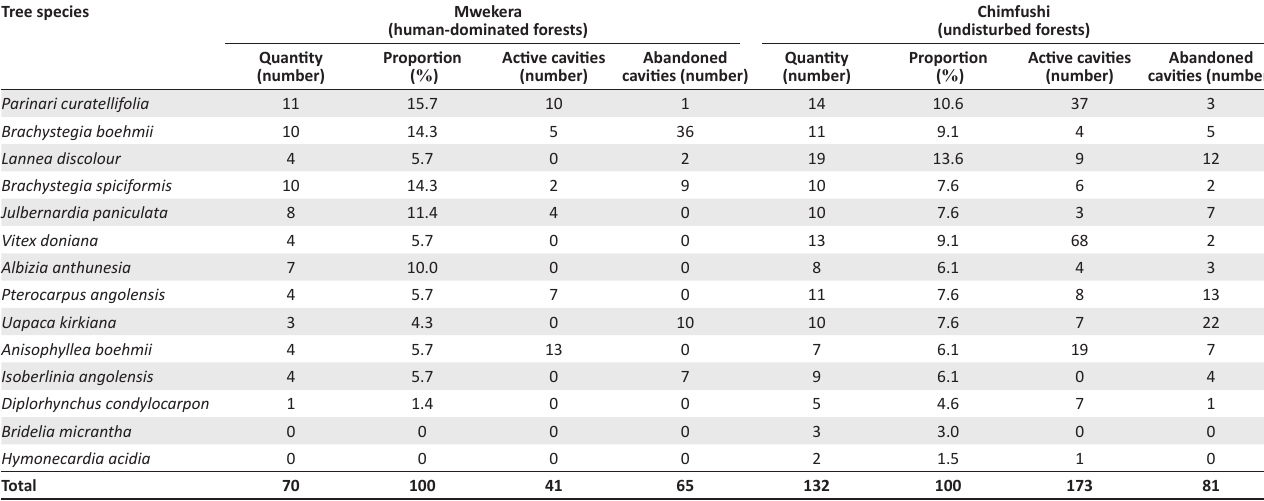
TABLE 3: Tree species and their associated nesting cavities in the 20 sample plots in Mwekera National Forests No. 6 and the Chimfushi Wildlife Orphanage forests, Copperbelt Province, Zambia, 2014. Tree species Mwekera (human-dominated